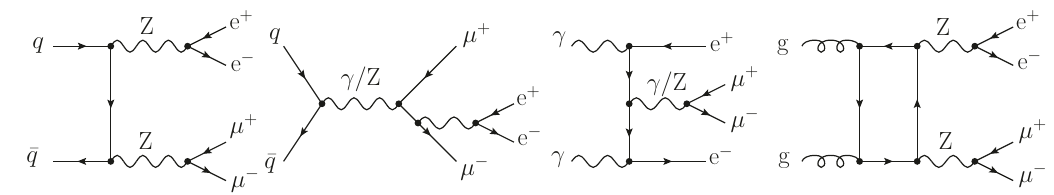
Figure 1 . Sample LO Feynman diagrams for four-charged-lepton production. From left to right: ZZ-resonant diagram in the q ¯ q channel, non-doubly-resonant diagram in the q ¯ q channel, non-doubly- resonant diagram in the γγ channel, ZZ-resonant loop-induced diagram in the gg